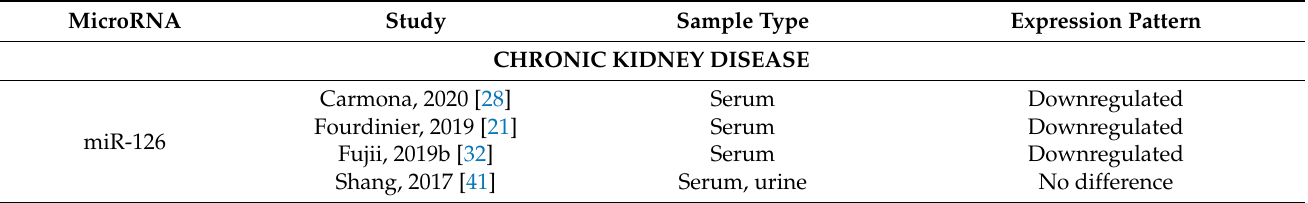
Table 4. MicroRNAs reported in at least three studies in chronic kidney disease